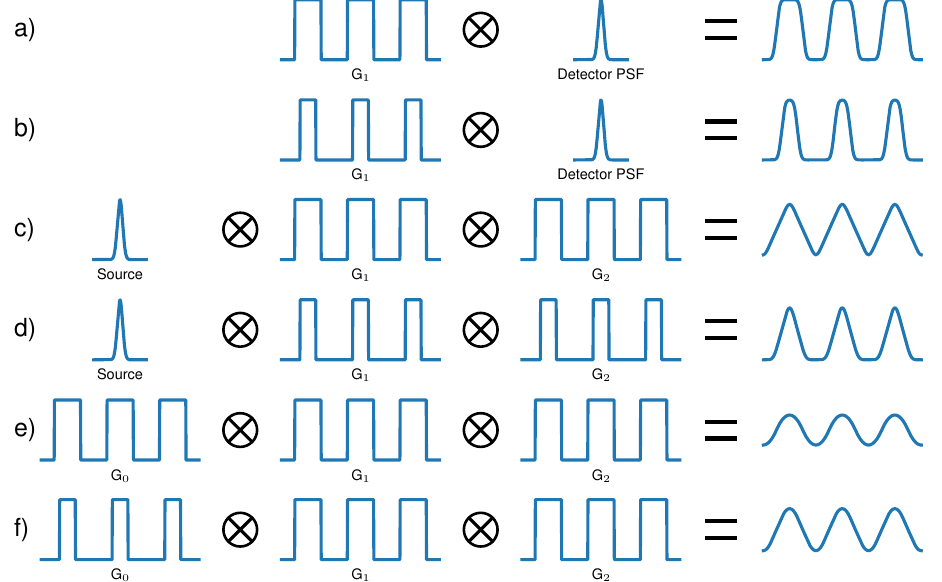
Figure 1. Origin of the resulting intensity modulation for different phase-sensitive imaging systems with periodic phase modulators. ( a ) Single grating system with a direct resolution of the intensity pattern can result in a trapezoidal modulation. ( b ) Single grating system with a smaller duty cycle (DC) resulting in an asymmetric modulation. ( c ) Two grating Talbot-interferometer operated with sufficiently coherent source resulting in a triangular modulation. ( d ) Two gratings with small DCs resulting in an asymmetric triangular modulation. ( e ) Three grating Talbot–Lau interferometer producing a quasi-sinusoidal modulation. ( f ) Talbot–Lau system with one grating having a small DC, resulting in deviations from sinusoidal